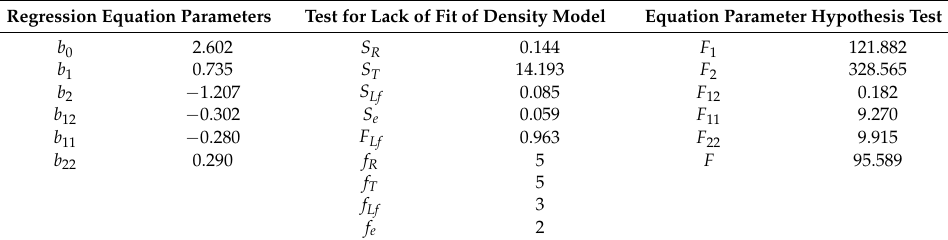
Table 6. Equation coefficients and statistical parameters of Canopy density model.